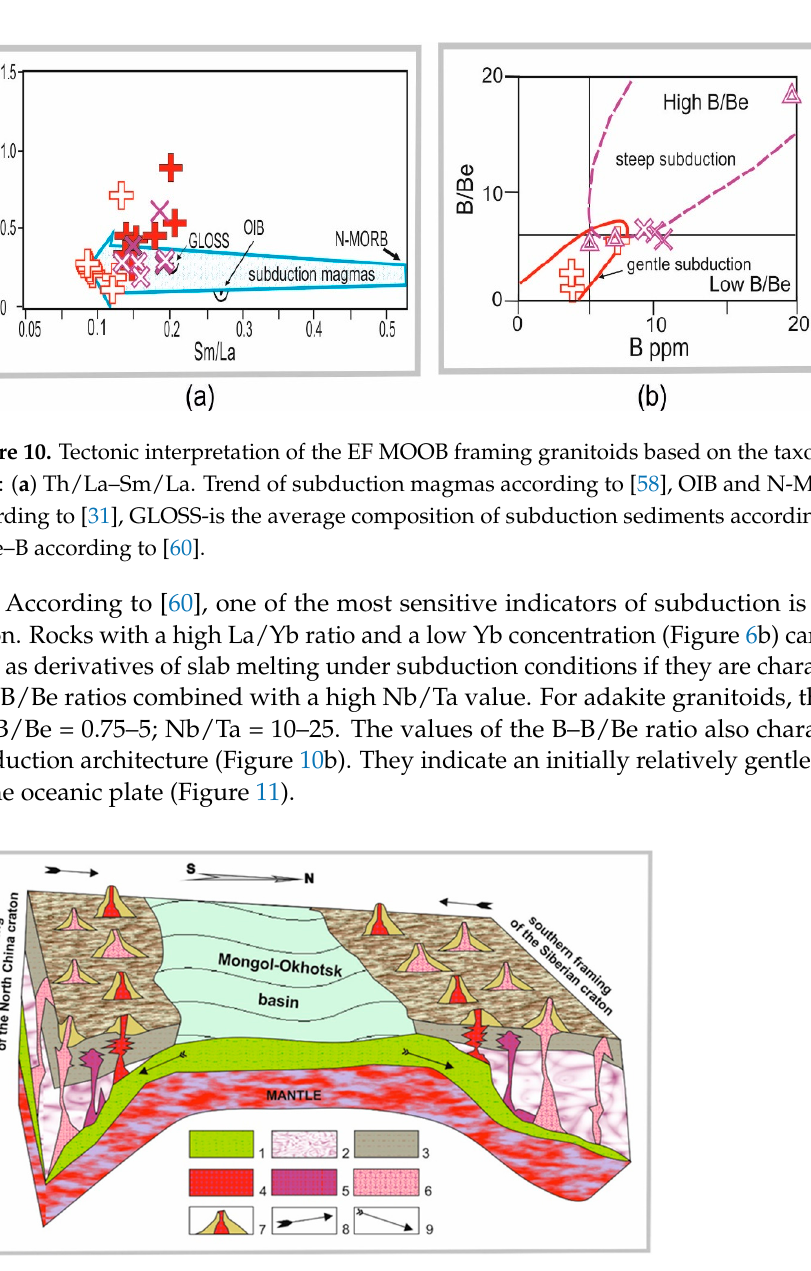
Figure 11. Schematic diagram showing the synchronous subduction of the Mongol-Okhotsk oceanic plate in the northern (under the southern framing of the Siberian Craton) and southern (under the northern framing of the North China Craton) directions in the interval 149–122 Ma. Legend: Oceanic crust (1). Metasomatized mantle (2). Continental crust (3). Magmatic complexes (4–6): adakite series, 149–138 Ma (4), calc-alkaline series-plutonic, 140–128 Ma (5) and volcano-plutonic, 130–122 Ma (6). Volcanoes (7). The direction of movement of cratons (8). The direction of movement of the oceanic crust (9).